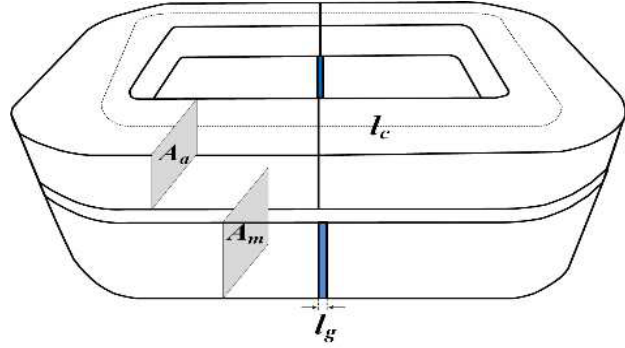
Figure 9. Drawing of integral heterogenous reactor.